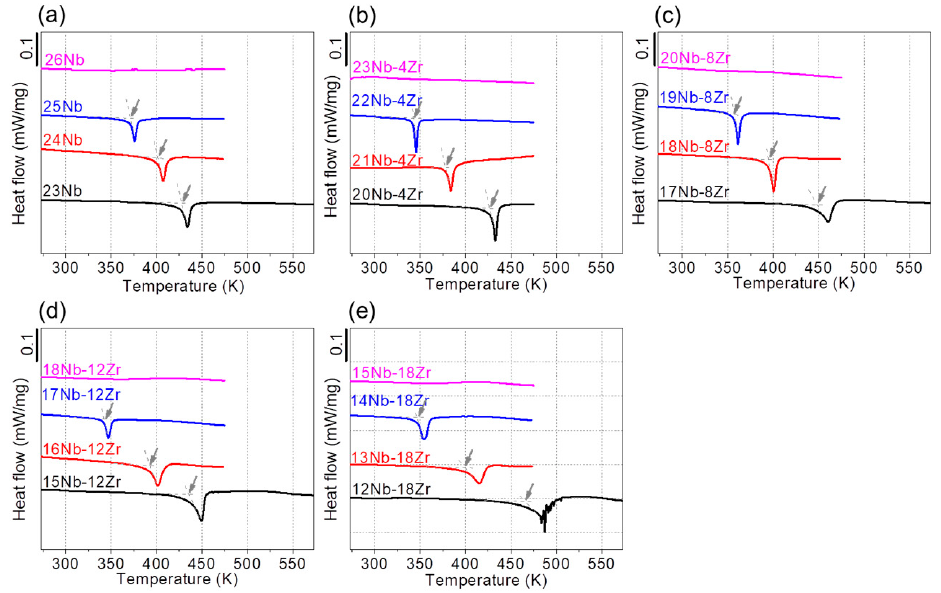
Figure 8. DSC curves of the Ti–Nb and Ti–Nb–Zr alloys upon heating: ( a ) Ti–(23–26)Nb; ( b ) Ti–(20–23)Nb–4Zr; ( c ) Ti–(17–20)Nb–8Zr; ( d ) Ti–(15–18)Nb–12Zr; ( e ) Ti–(12–15)Nb–18Zr